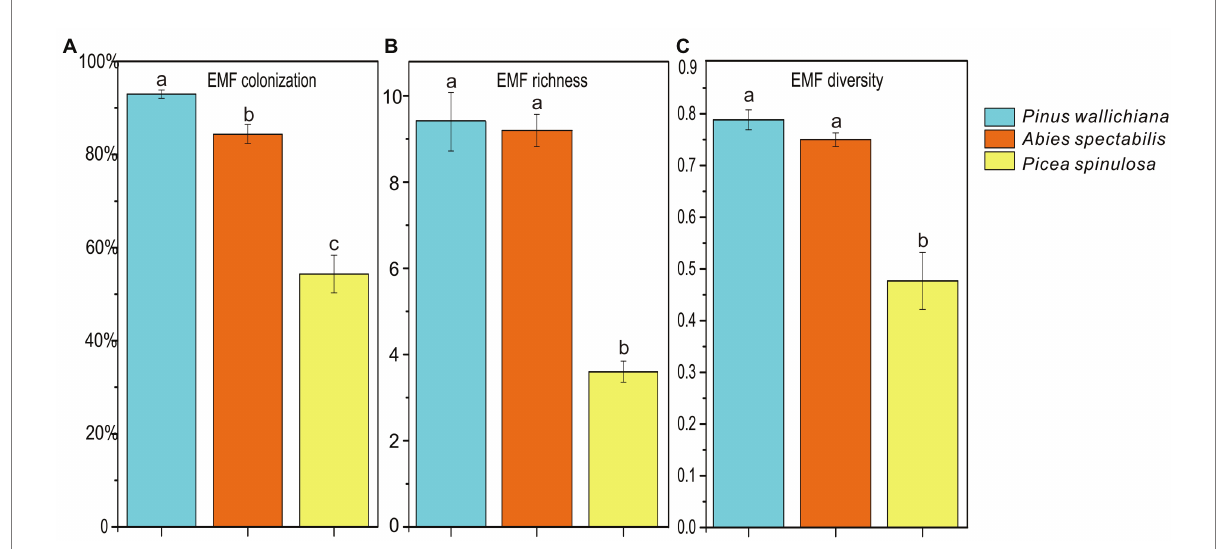
FIGURE 1 Ectomycorrhizal fungal (EMF) colonization (A) and alpha-diversity indices (B, C) across three coniferous forests. Different letters indicate significant differences at p < 0.05 (ANOVA) between means ( n =